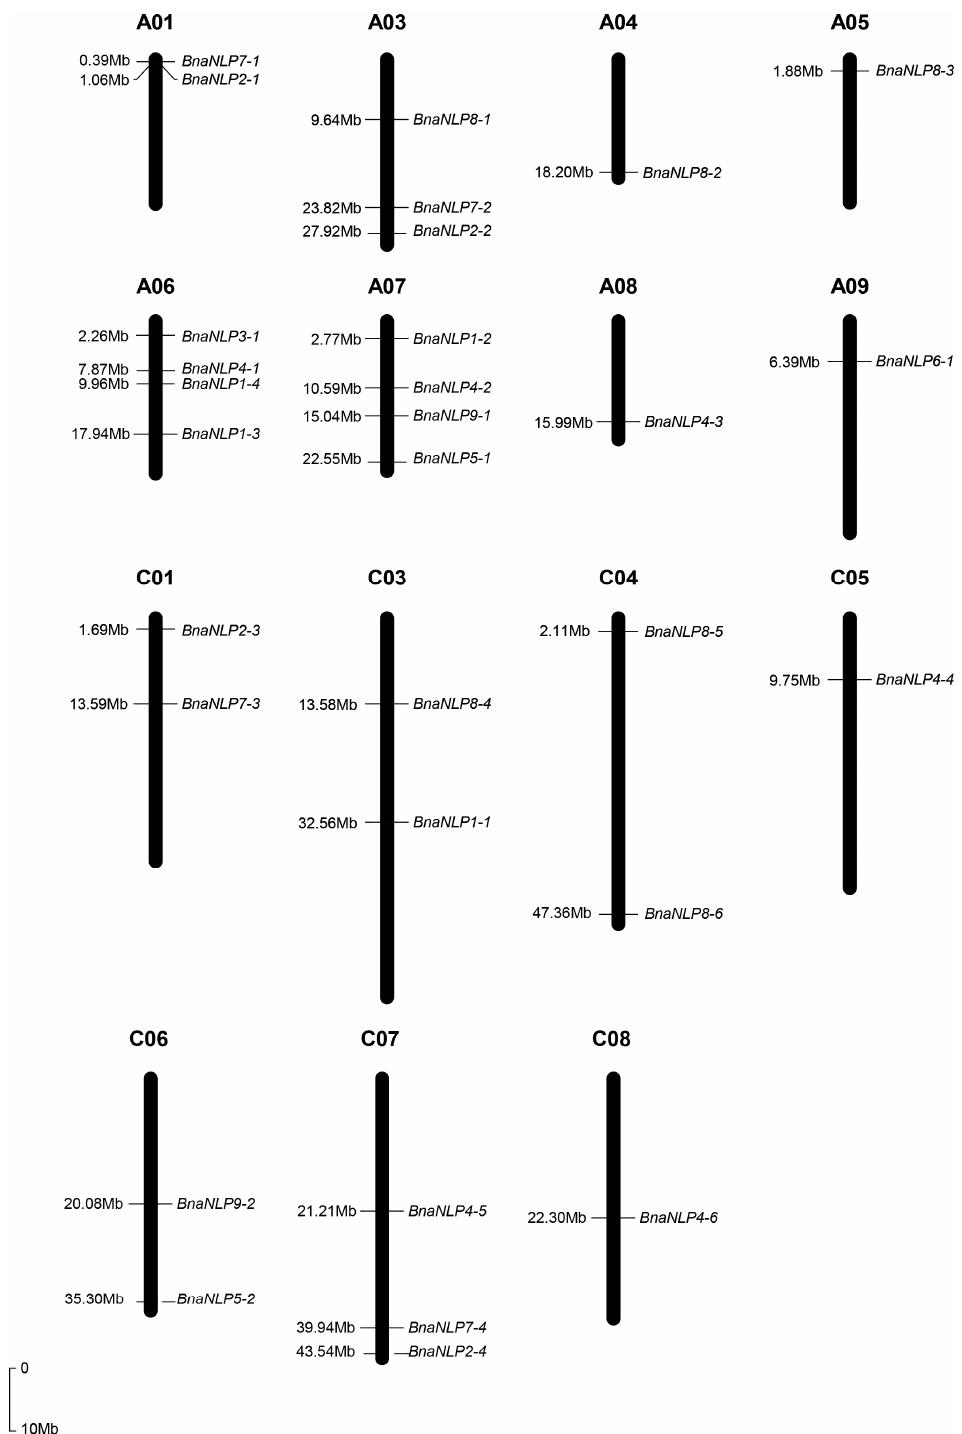
Figure 3. Chromosomal distribution of BnaNLP genes in the B. napus genome. Chromosomal information for BnaNLP genes was obtained from the B. napus genome annotation results and mapped to the corresponding chromosomes. The scale bar indicates the genome size of B. napus .